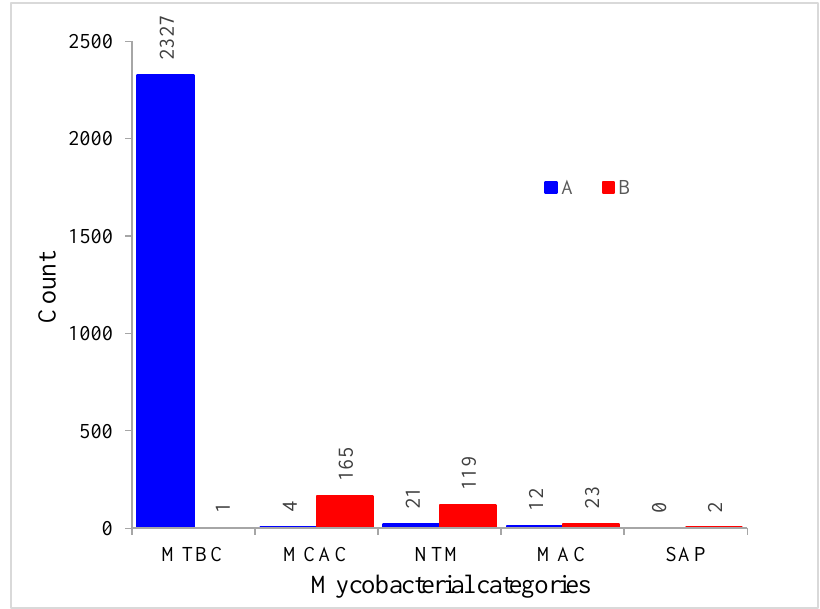
Figure 3. Comparative analysis of CYP128 P450 subfamilies in five different mycobacterial